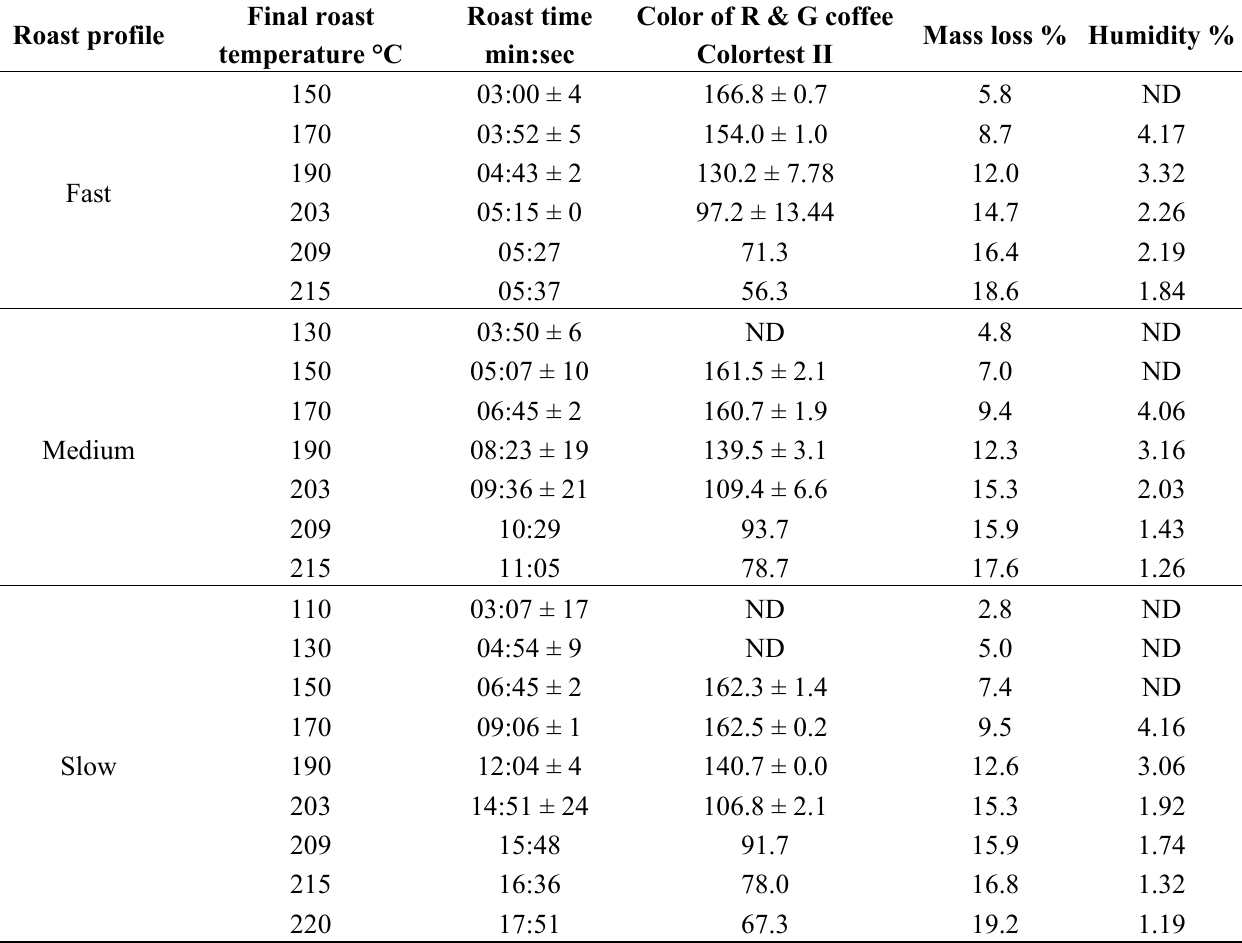
Table 1: Summary of roasting data for Arabica coffee samples for different profiles and roasting degrees ( n =